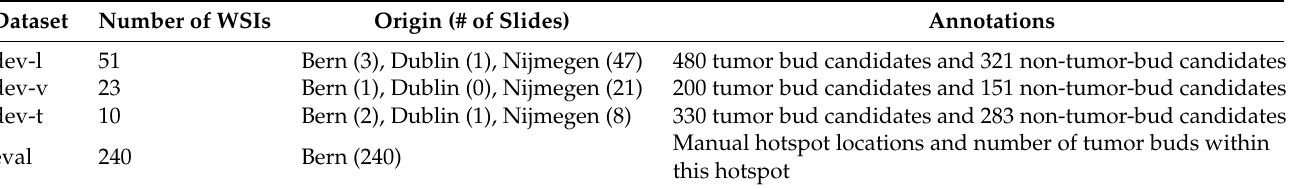
Table 1. Overview of the different datasets used in this